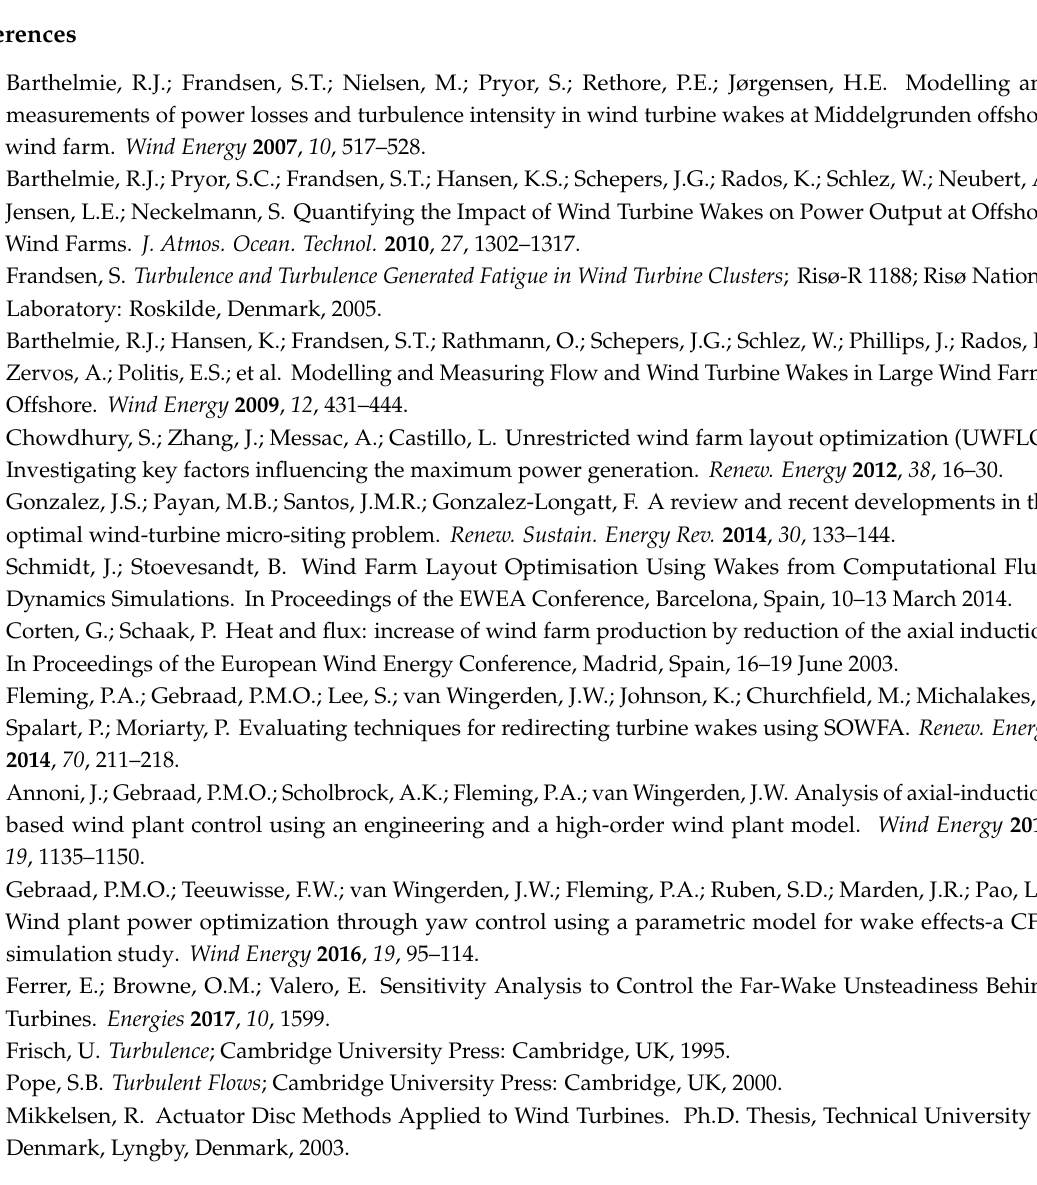
Figure A3. Sections of the time series of the different loads for original LES and for the spectral model with added turbulence including N = 6